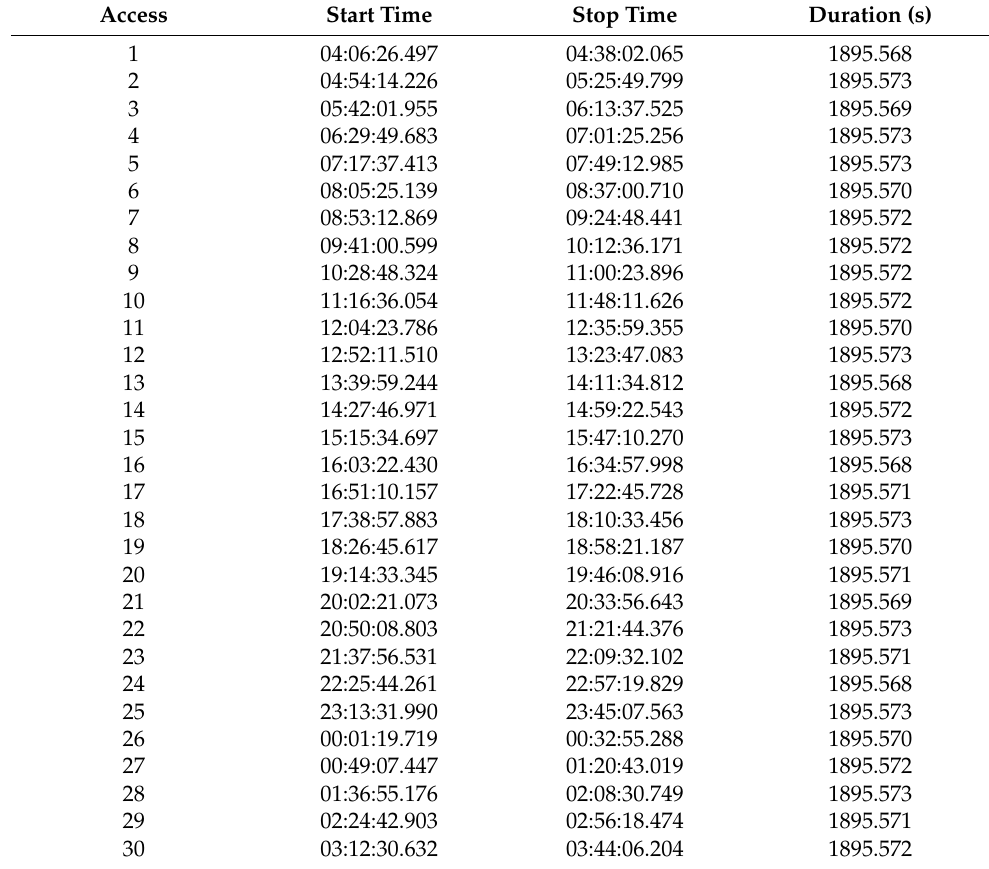
Table 4. Temporary LISLs between S ( 2,1 ) and S ( 5,1 )